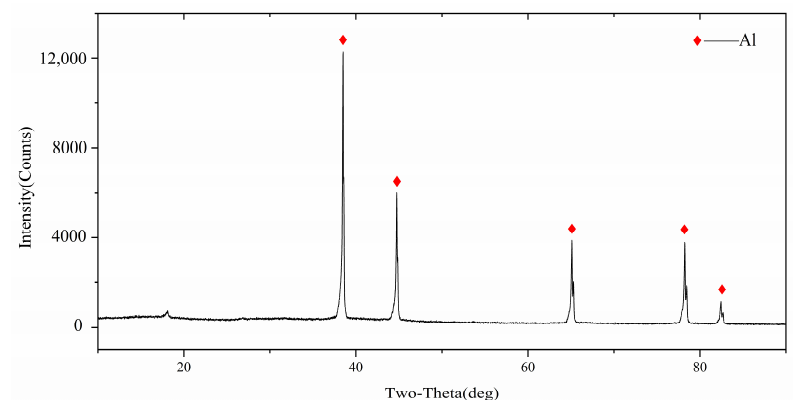
Figure 4. XRD of the micro-nano composite aluminum powder.